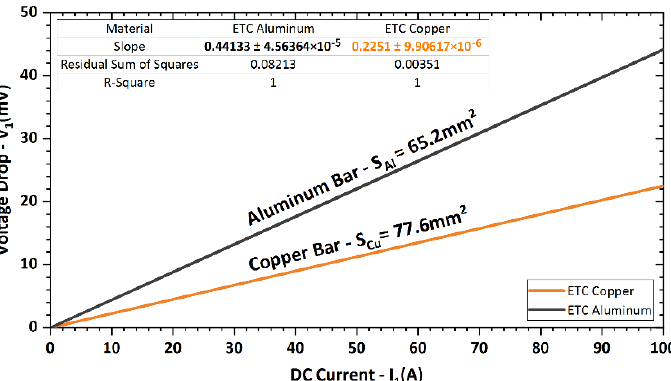
Figure 2. Measured voltage drop V 1 in dependence on applied current I 1 for original metals.